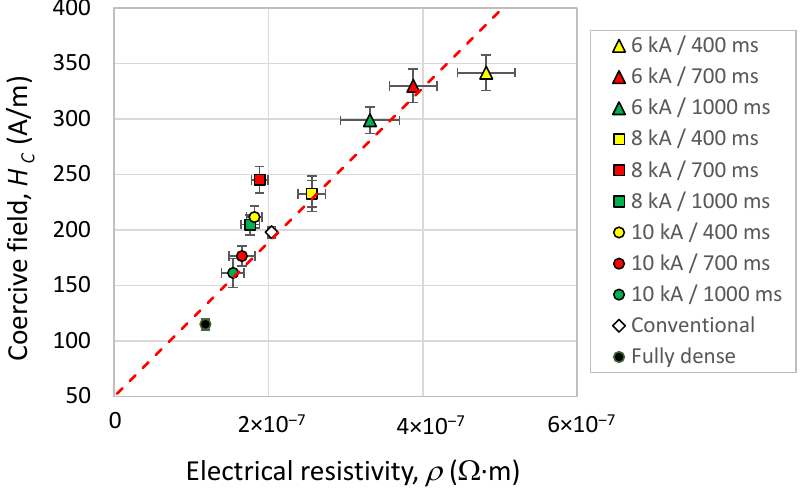
Figure 11. Coercivity ( H C ) vs. electrical resistivity ( ρ ) of the different compacts studied in this work.